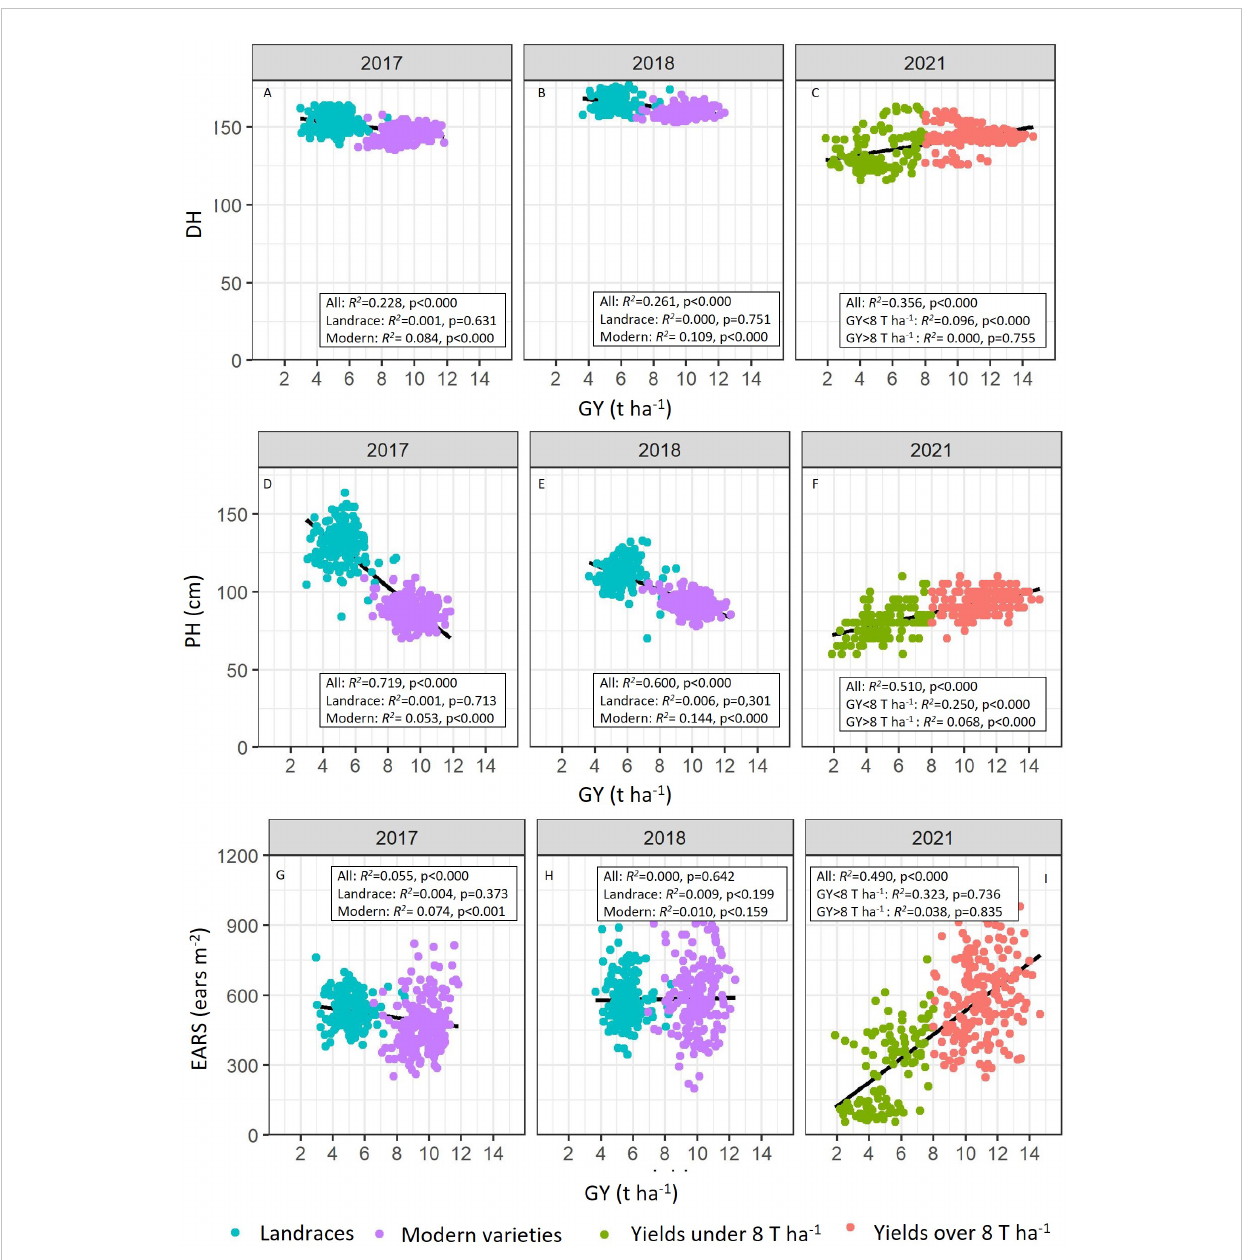
FIGURE 3 Linear relationships between grain yield (GY, t ha-1) and the number of days to heading (DH) ( A , 2017; B , 2018; C , 2021), plant height (PH, cm) ( D , 2017; E , 2018; F , 2021), and ear density (EARS, ears m-2) ( G , 2017; H , 2018; I , 2021). Coef fi cients of determination (R2) and associated probabilities are